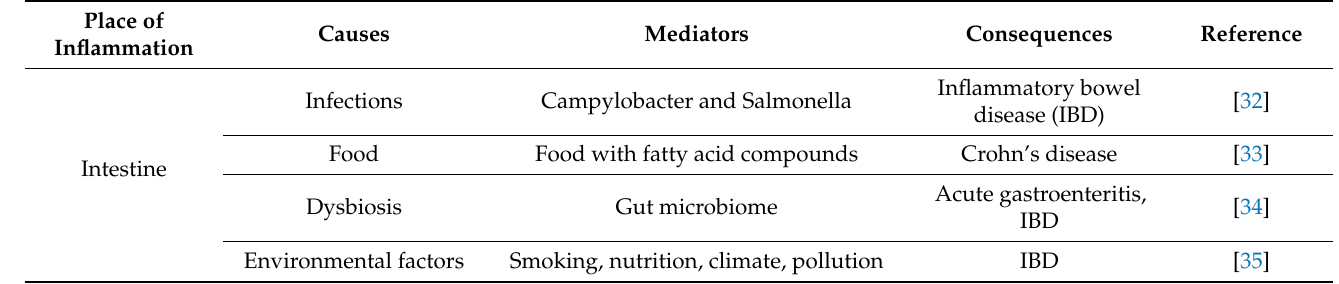
Table 1. Summary of the inflammatory processes in different body organs.